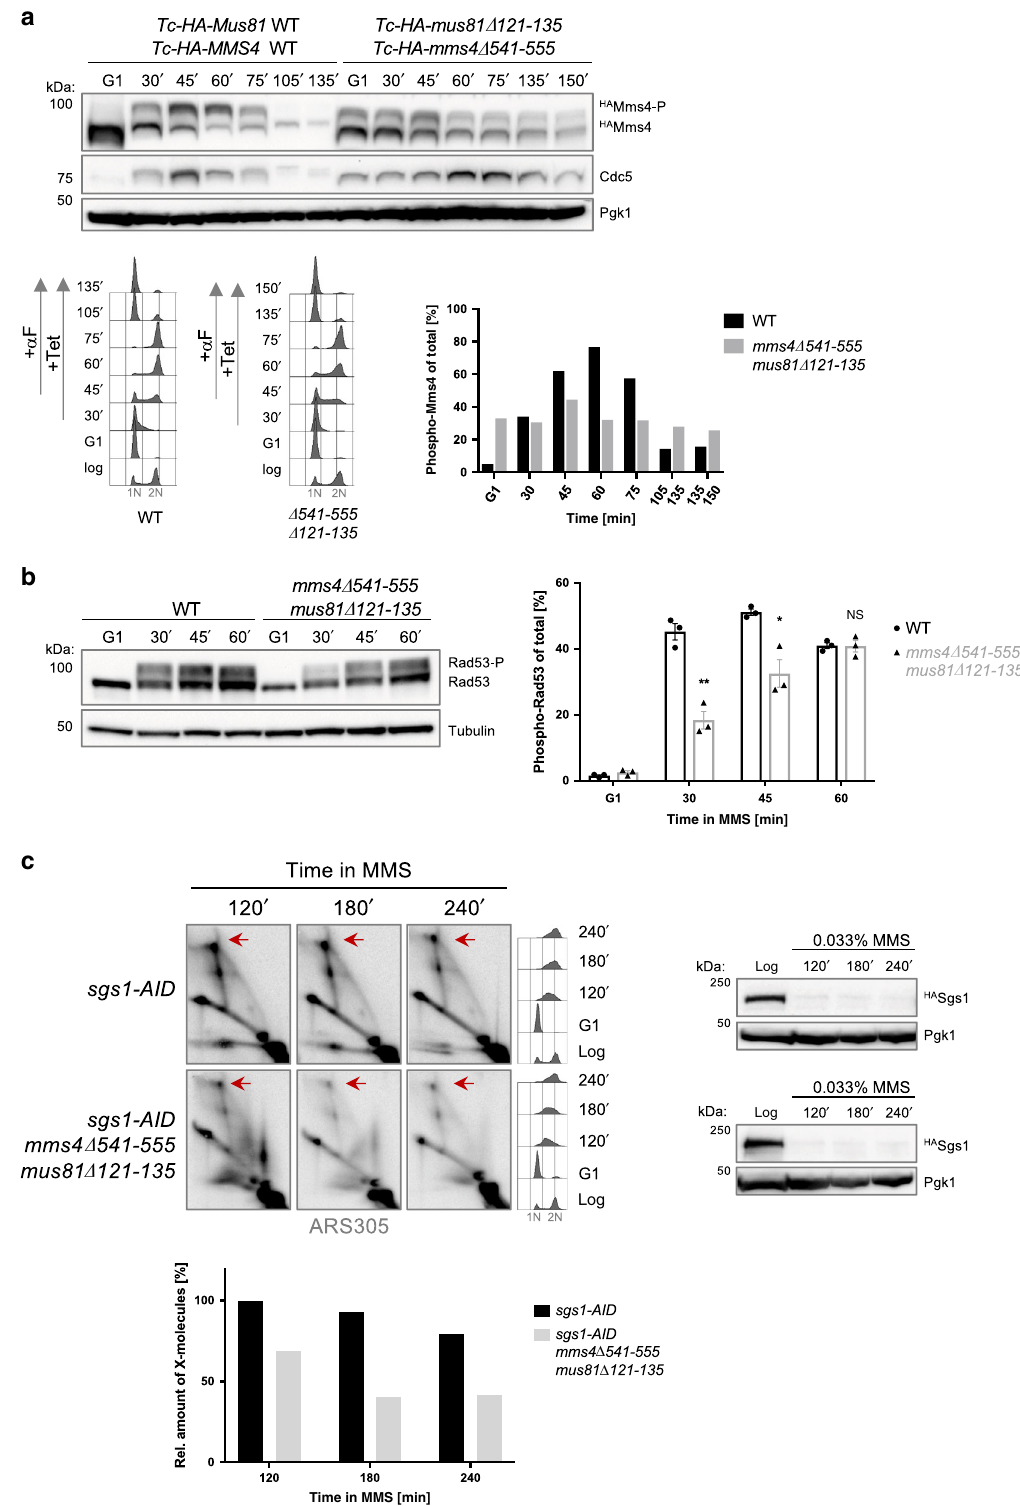
Supplementary Fig. 2, Figs. 2 and 3, Supplementary Fig. 3, and Fig. 7) or the nuclease activity was measured (Fig. 4b) were repeated at least twice independently to con fi rm the result. For cell fractionation experiments, as well as experiments in which Rad9 or Rad53 levels were measured (Figs. 4a, 6, and 7), three or four experiments were used to allow statistical analyses. The mean values of three or four experiments were calculated and shown with corresponding SEM. Statistical analyses were performed using a two-tailed unpaired t test with Welch ’ s correction and the Graphpad Prism software. A P value of <0.05 was considered